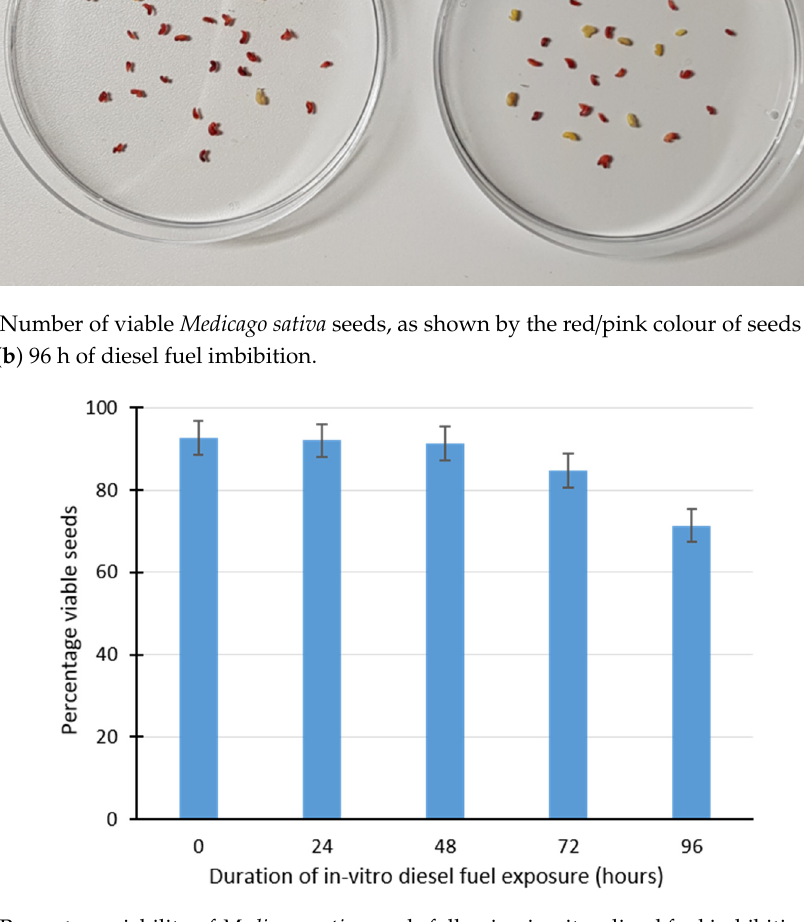
Figure 3. Percentage viability of Medicago sativa seeds following in vitro diesel fuel imbibition based on the triphenyltetrazolium chloride test. Error bars indicate standard errors.